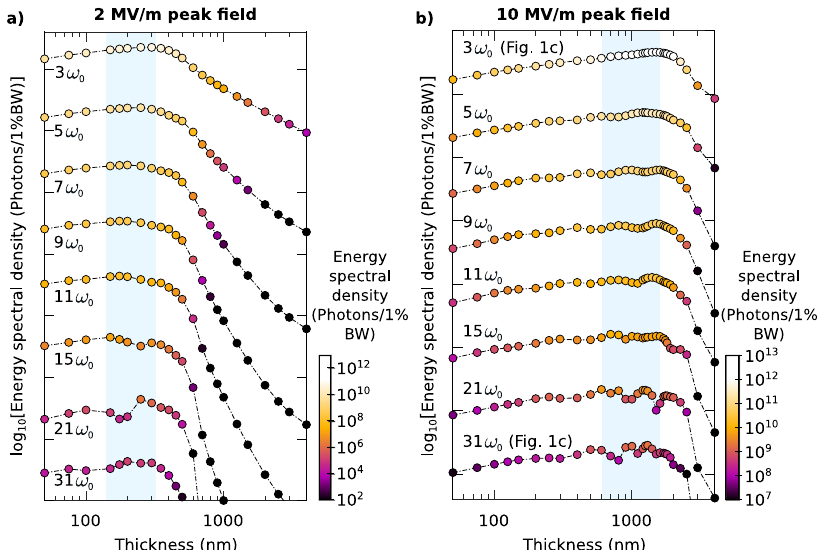
Fig. 3 Optimizing fi lm thickness for HHG in 3D Dirac semimetals (DSMs). a For a 3D DSM fi lm driven by a pulse of peak amplitude 2 MV/m and central angular frequency ω 0 = 2 π × 1 THz, the optimal thickness for all harmonics falls between 150 and 300 nm. For a larger driving fi eld of 10 MV/m b the optimal thickness of all harmonics lies between 600 and 1600 nm. The optimal thicknesses for all harmonics from the 3rd to the 31st lie within the blue shaded areas. The optimal thickness generally shifts to larger values when driven by stronger fi elds. In both panels, the N th curve from the top has been translated downwards by 10 4( N − 1) for visual clarity; the color of the data points represent their actual magnitudes in units of photons/1% bandwidth (BW). We consider the same parameters as Fig.